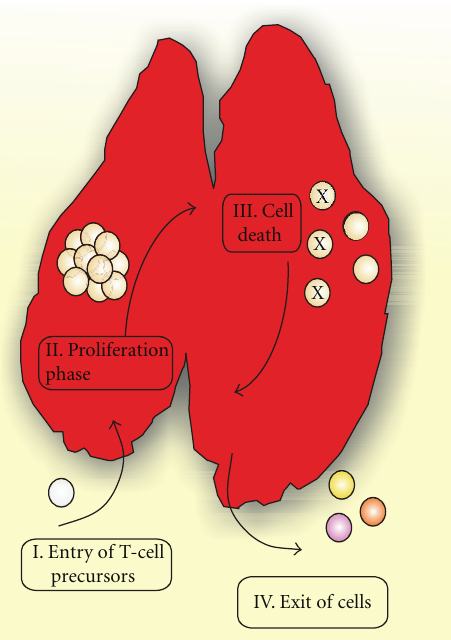
Figure 2: Possible mechanisms involved in thymic atrophy. I. Decreased number of precursor cells migrating into the thymus, II. Lower capacity in thymocyte proliferation during T-cell di ff erentia- tion, III. Increased thymocyte death, and/or IV. Exit of immature T cells to peripheral